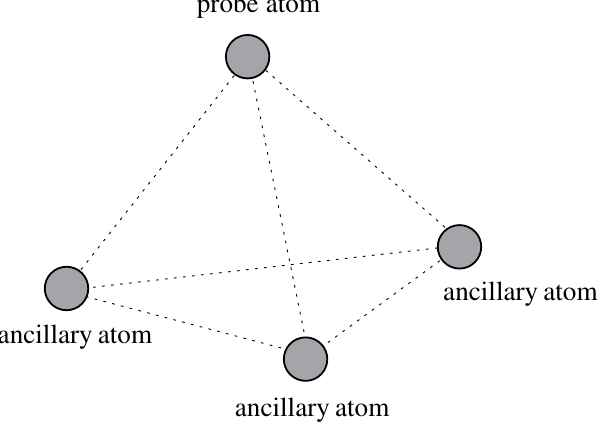
Figure 1. The probe atom and the three ancillary atoms located in the vertex of regular